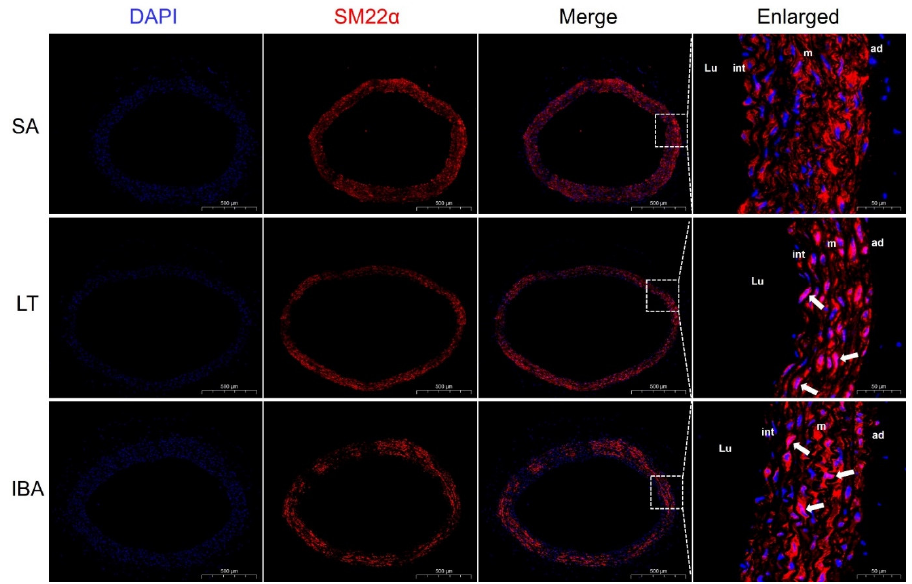
Figure 6. Immunofluorescence staining of SM22α in the thoracic aorta of ground squirrels. DAPI (blue) labels the nucleus, and CY3 (red) labels nuclear SM22α. The scale in the left column = 500 μm and in the right column = 50 μm. White arrows are nuclear translocation changes. SA: summer ac- tive, LT: late torpor, IBA: interbout arousal, Lu: lumen, int: intima, m: media, ad: adventitia.